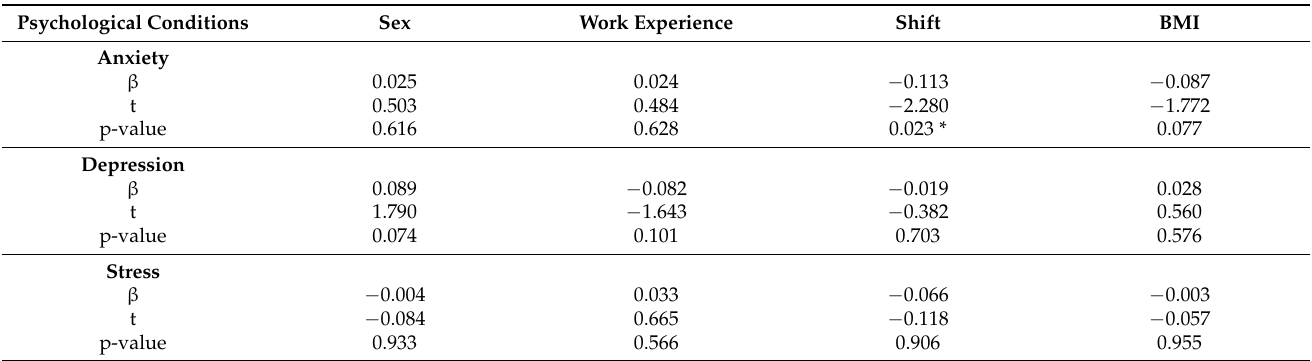
Table 4. Linear regression between the sampling characteristics and anxiety, depression and stress